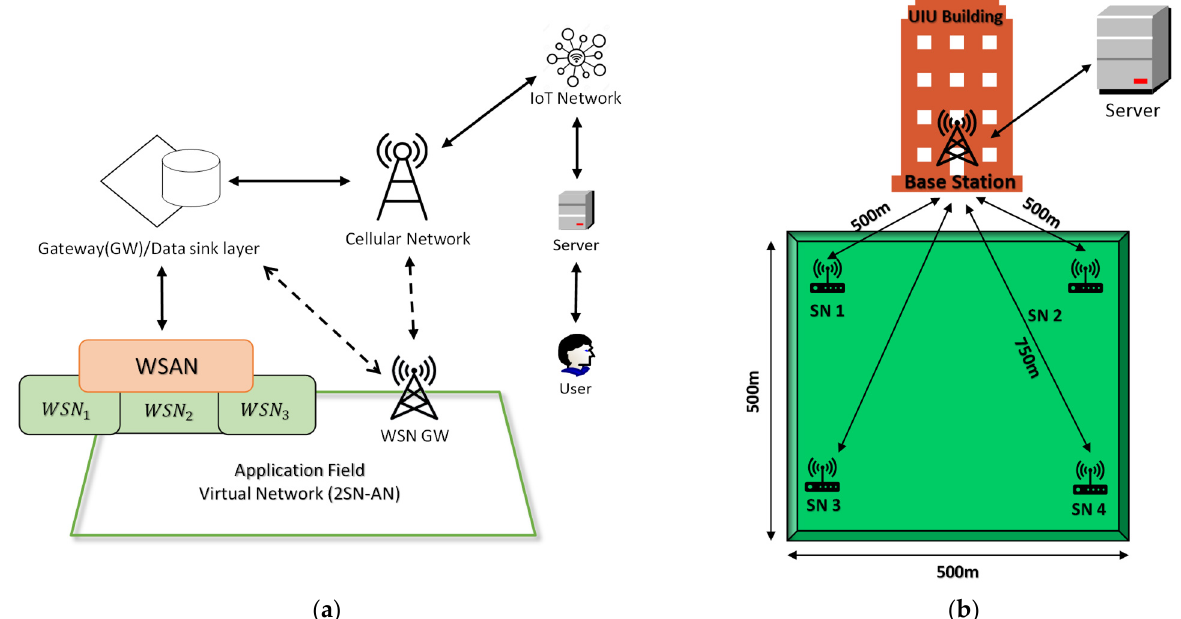
Figure 10. ( a ) IoT-connected WSAN architecture ( b ) On-campus trial setup with sensor devices connected to a base station IoT-connected WSAN architecture.